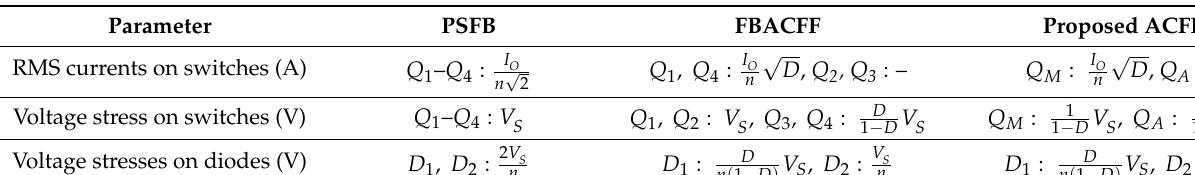
Table 2. Stress comparison of primary switches.